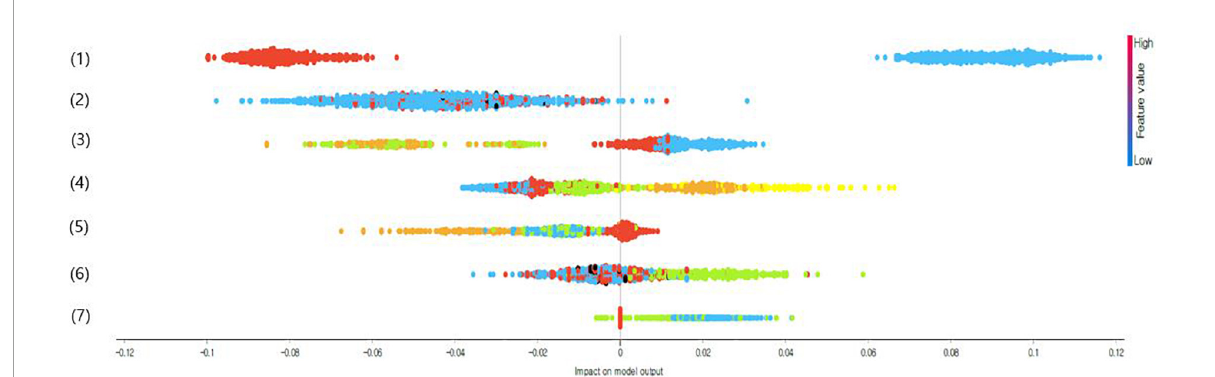
FIGURE1 Impact on model output of adolescent obesity predictors using categorical boosting (CatBoost’s) shapley additive explanation (SHAP) values (only top seven variables are presented); (1) Gender (1 = male or 2 = female), (2) mean sitting hours per day (1 = less than 6 h or 2 = 6 h or more), (3) number of days of conducting strength training in the past seven days (1 = none, 2 = 1–2 days, 3 = 3–4 days, or 4 = 5 days or more), (4) academic performance (1 = high, 2 = medium-high, 3 = medium, 4 = medium-low, or 5 = low), (5) the number of days of drinking soda in the past seven days (1 = none, 2 = 1–2 days, 3 = 3–4 days, or 4 = 5 days or more), (6) the number of days of conducting the moderate-intensity physical activity for 60 min or more per day in the past seven days (1 = none, 2 = 1–2 days, or 3 = 3 days, and more), and (7) stress perception level (1 = high, 2 = moderate, or 3 =